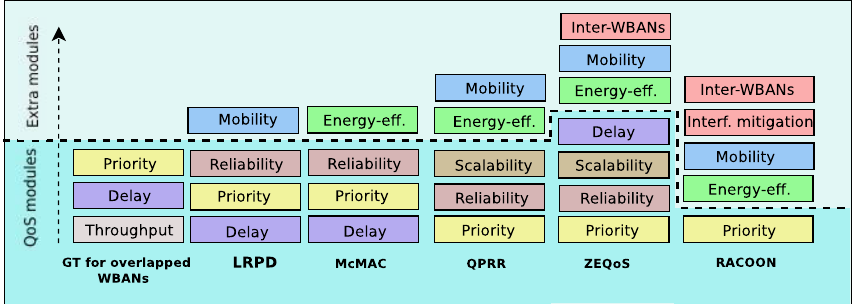
Figure 5. Quality-of-service (QoS) modules of WBAN QoS protocols suitable for future BBNs. c (cid:13) [2019] IEEE. Reprinted and modified, with permission, from